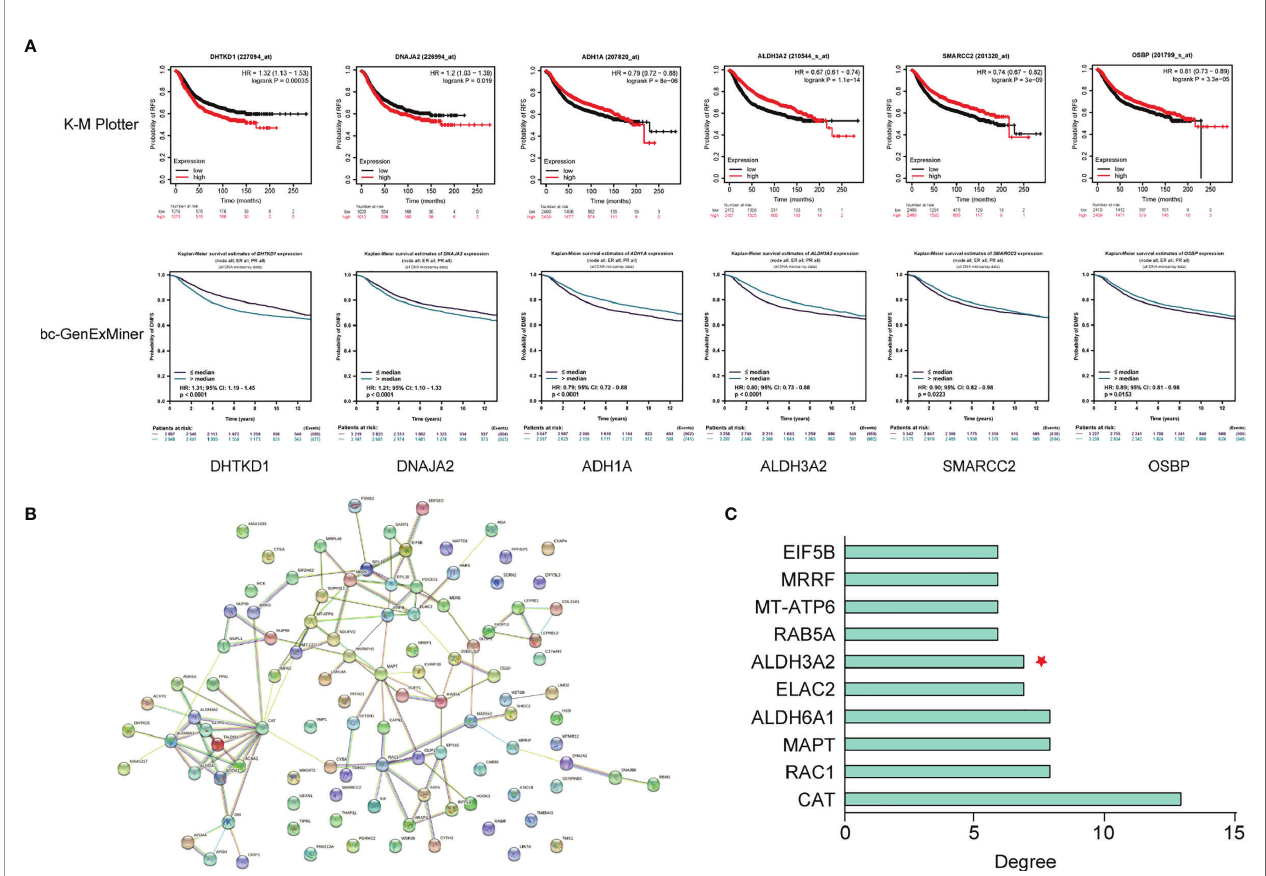
FIGURE 6 | Identi fi cation of ALDH3A2 as a potential biomarker associated with tumor recurrence in the pCR patients. (A) Survival analysis of six differentially expressed genes (DEGs) in K-M Plotter and bc-GenExMiner databases. (B) The PPI network of the DEGs. (C) Hub genes of the DEGs. K-M Plotter, Kaplan-Meier Plotter; PPI network, protein-protein interaction